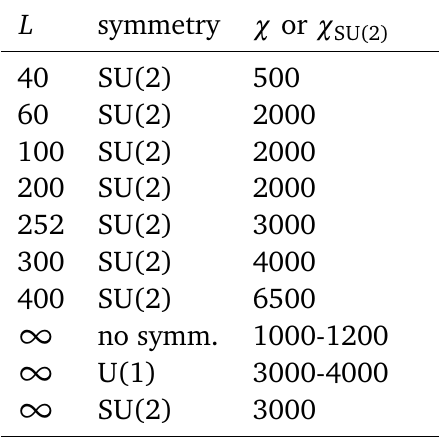
Table 1: Typical bond dimensions and system sizes used in this work in terms of the system size L and the symmetries exploited in the algorithm. For finite systems, we always use periodic boundary conditions. For L = ∞ and the case of SU(2), we = 0. Note that for SU(2) and the S = 0 sector, the can only access the sector S tot tot = g · χ effective bond dimension is χ with a gain factor of g ∼ 5 − eff SU(2)